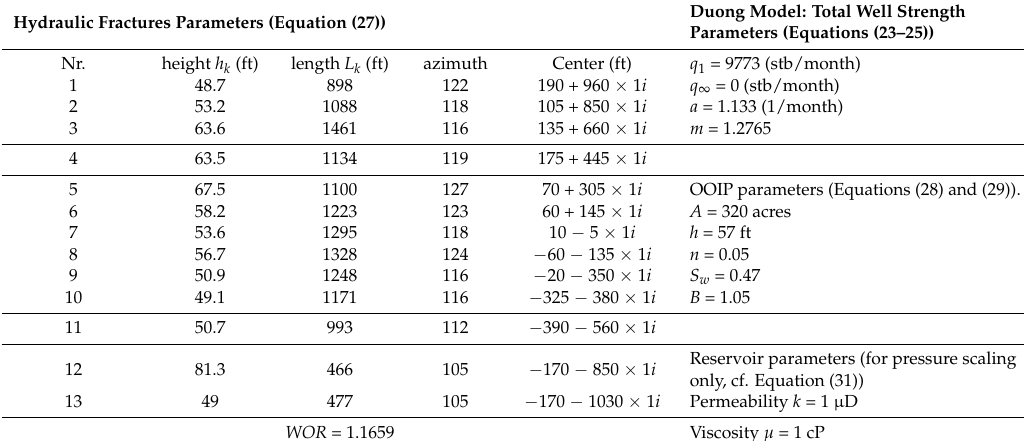
Table 1. Key parameters used in this study.